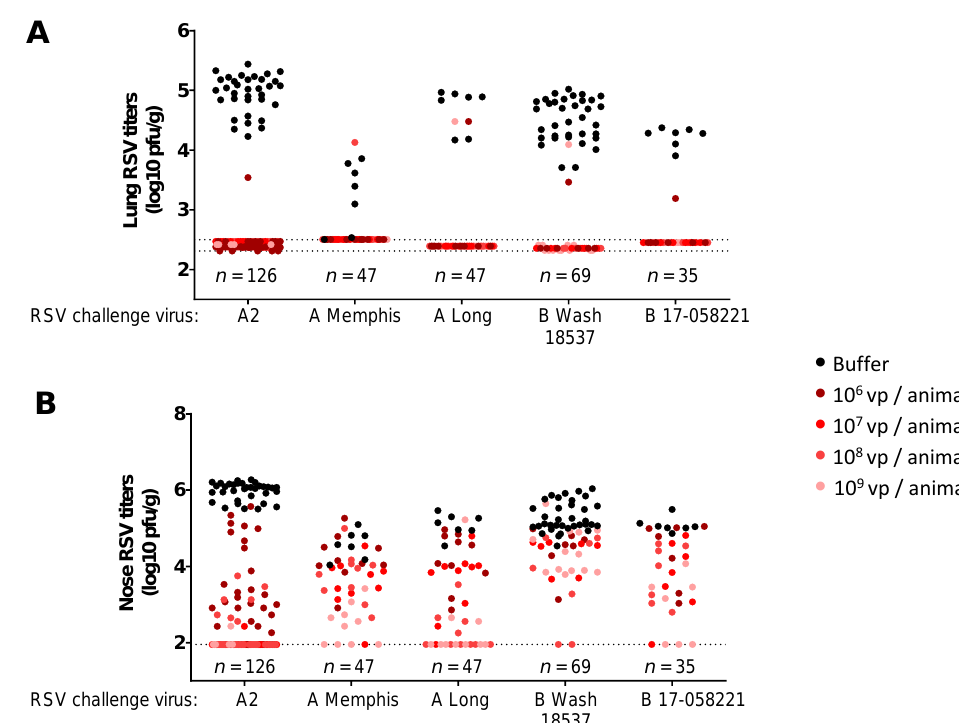
Figure 3. Immunization with Ad26.RSV.preF confers protection against challenges with RSV A and RSV B strains in naïve cotton rats. Cotton rats were immunized with 10 6 to 10 9 vp of Ad26.RSV.preF at day 0, and challenged with RSV A2, RSV A Memphis, RSV A Long, RSV B Wash 18537 or RSV B 17-058221 at week 7. RSV viral load was determined by plaque assay in homogenates of the lung ( A ) or nose tissue ( B ) isolated at day 5 post-challenge and expressed as log10 plaque forming units (pfu) per gram of tissue. Compiled results from multiple challenge studies are shown (five studies for RSV A2, one study for RSV A Memphis, one study for RSV A Long, four studies for RSV B Wash 18537 and one study for RSV B 17-058221), with total numbers of animals per challenge strain shown in the figure, and number of animals per Ad26.RSV.preF dose level (indicated with different colored dots) ranging from seven to forty-two. Pooling of results of several different studies is considered justified, as viral loads in the control groups were within acceptable ranges between the separate studies that use the same challenge strain. The limit of detection of the plaque assays is indicated with dotted lines.